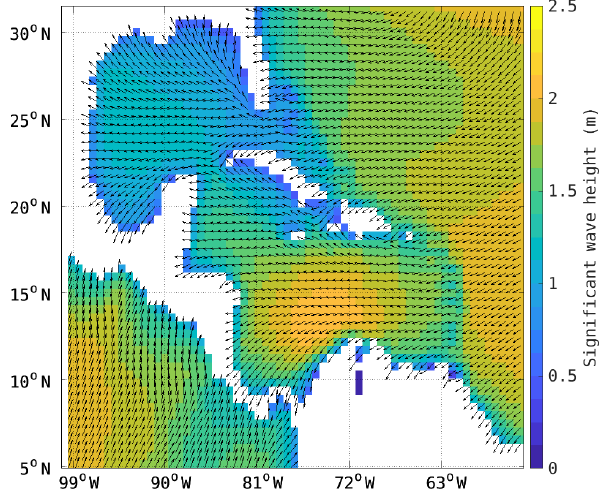
Figure 6. Mean significant wave height (m; colour shading) and mean direction (vectors) from the global 37-year historical- climatology wave model